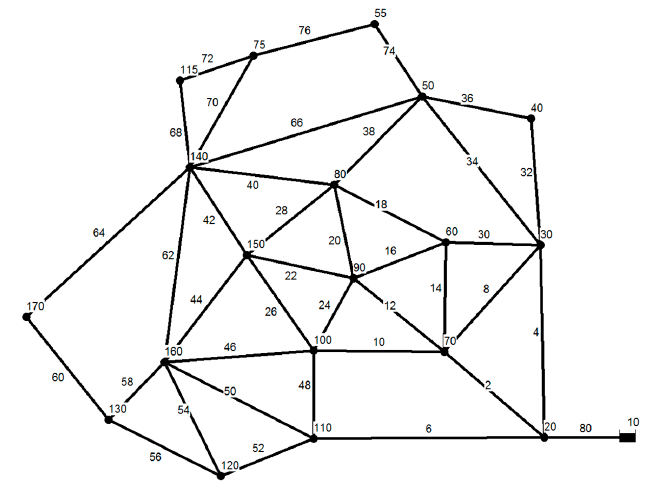
Figure 4. Shape of Anytown Network.